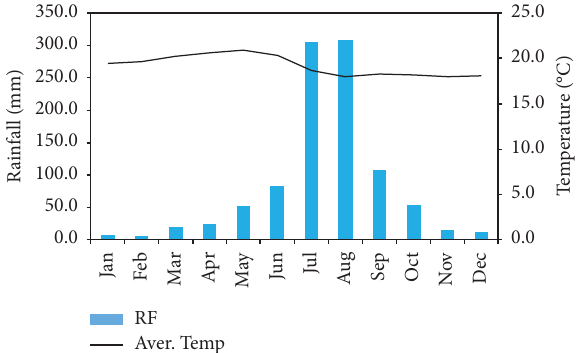
Figure 2: Monthly average rainfall and temperature distribution of Lay Gayint in the 2020 cropping